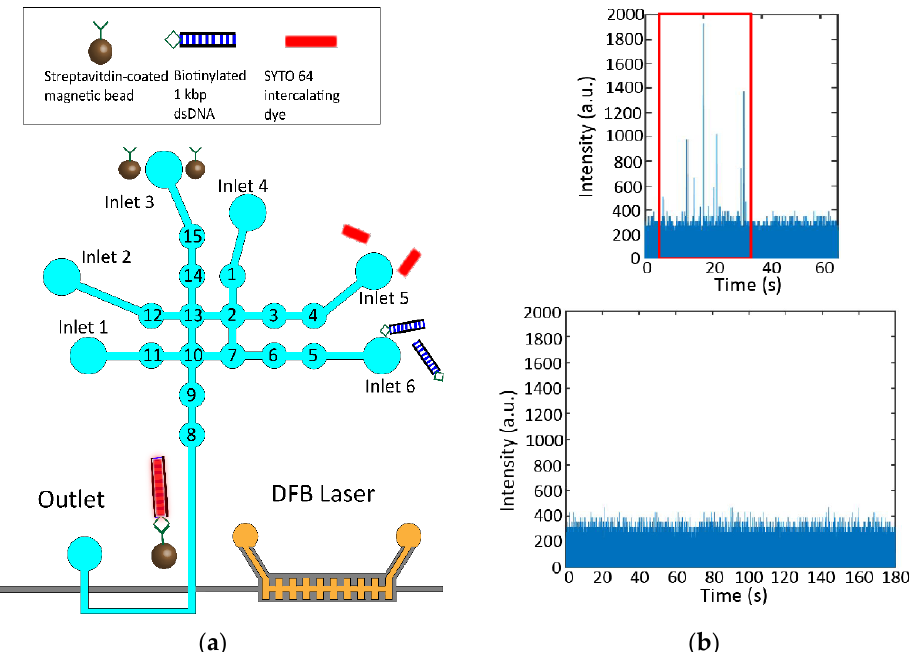
Figure 5. ( a ) Non-specific biomarker detection. Streptavidin-coated magnetic beads with capture probes are loaded into inlet 3 while the SYTO 64 intercalating dye and biotinylated 1kbp dsDNA are introduced into inlets 5 and 6, respectively. Inlets 1, 2, and 4 were loaded with 1xPBS buffer. Samples are brought together into the central mixing valves (13, 2, 7, 10) where they are mixed and incubated for the proper construct to be formed. Beads with captured fluorescently stained targets are pulled down with a magnet while excess targets and unconjugated probes are washed using buffer. The magnet is then removed, and the complete bead constructs are pushed to the detection region. ( b ) Fluorescence time domain trace illustrating peaks observed from fluorescently stained bead constructs (top). Control trace done in the absence of dsDNA targets illustrating no peaks above the noise floor (bottom).